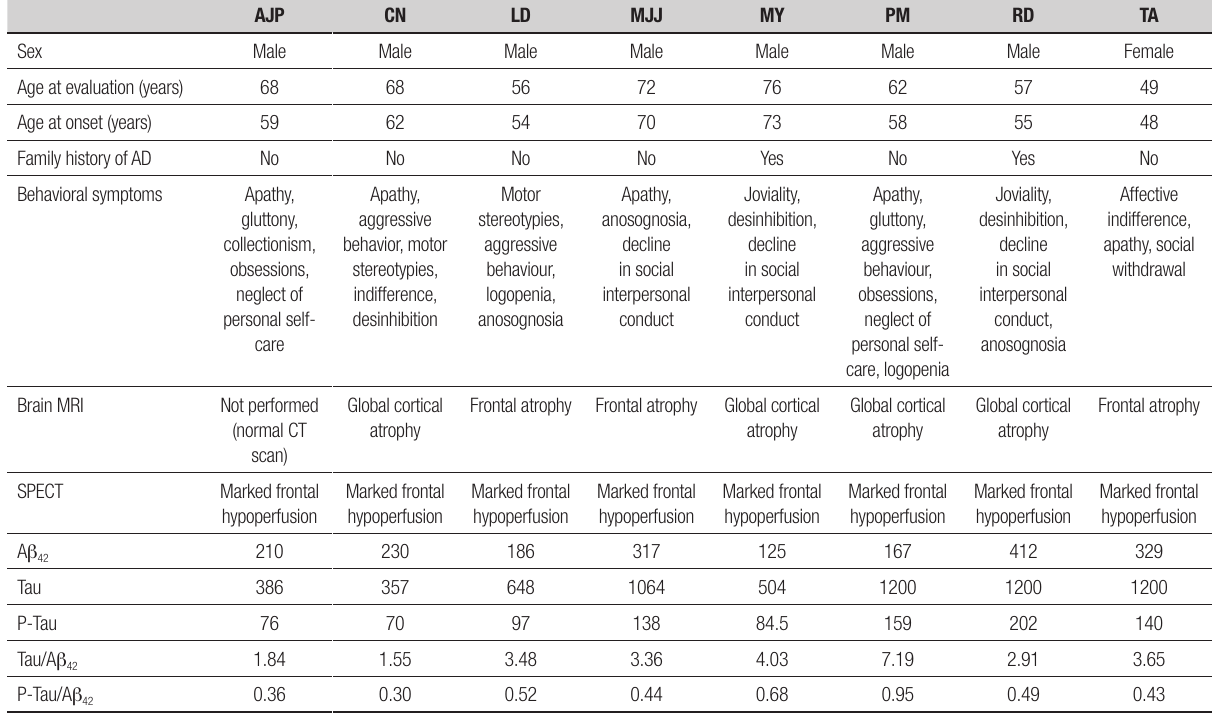
Table 1. Demographic, clinical, neuroimaging and CSF data for each patient.